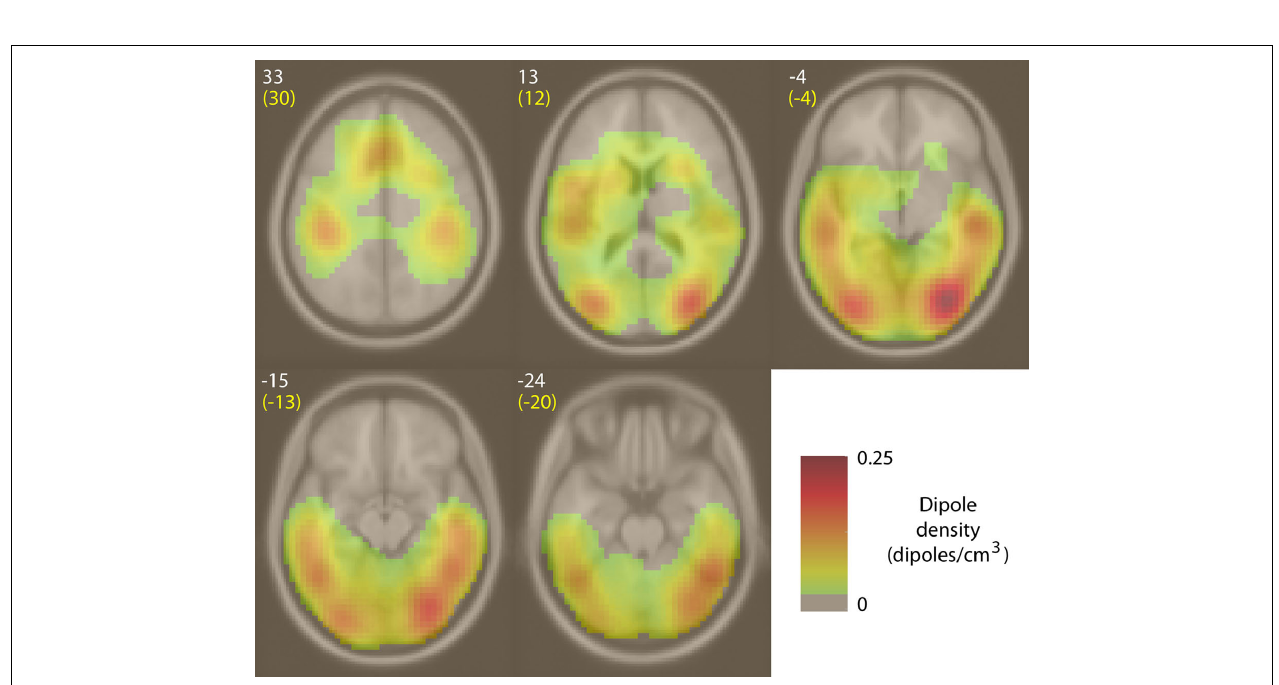
the 15 emotion terms by a separate subject cohort. The solid line shows the best-fi t regression direction ( r = 0.96) predicting mean rated valence for each emotion term from its location in the 2-D MDS space solely based on IM weights after neglecting compassion (see text). The dashed line orthogonal to this cleanly separates positive-valence emotions terms (warm color balls) from negative-valence terms (cool color balls).